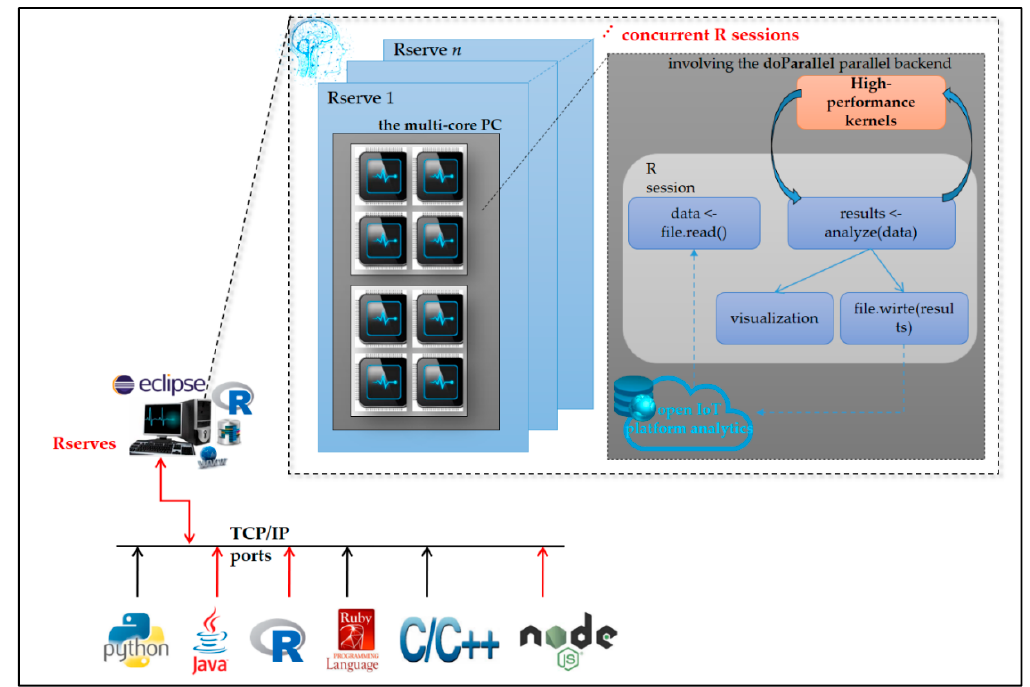
Figure 4. Rserve() in R language conducted and configured on the data science analytics engine for high-performance parallel processing/computing.